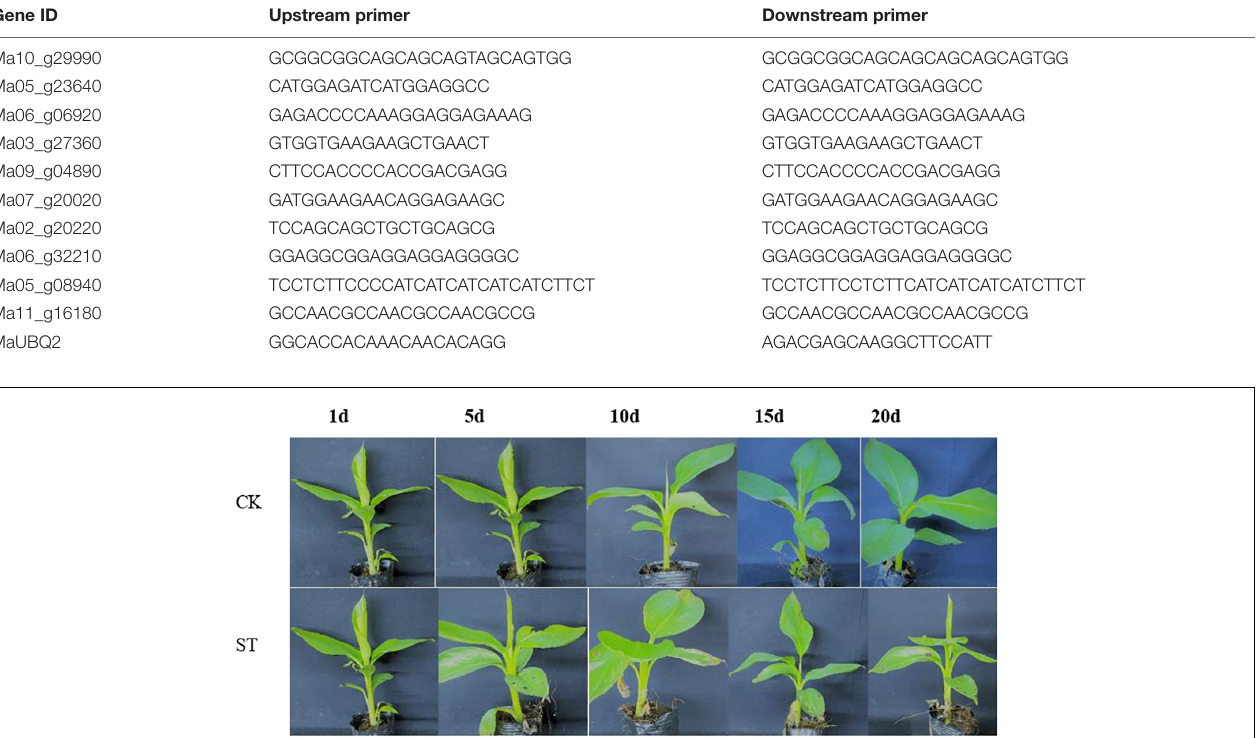
TABLE 1 | Primers used for qRT-PCR analyses.